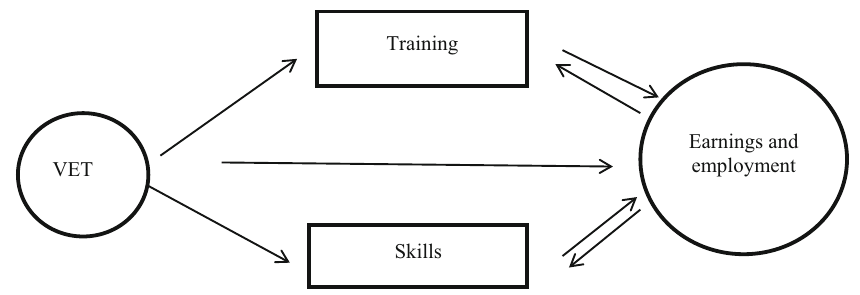
Fig. 1 The relationship between VET and labour market outcomes